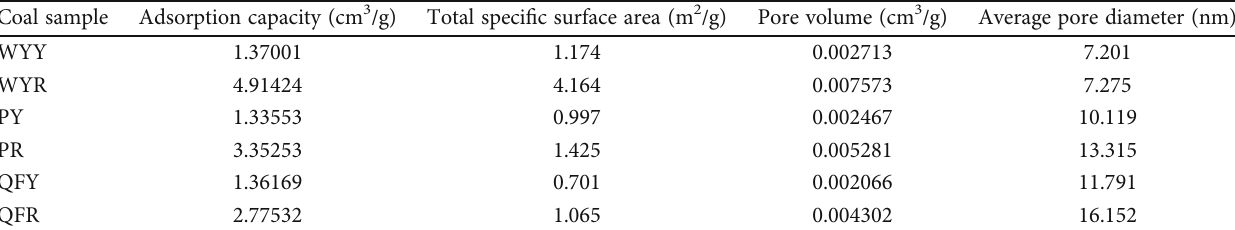
Figure 3: The adsorption/desorption curves of di ff erent rank coal samples. Table 4: Test results of coal